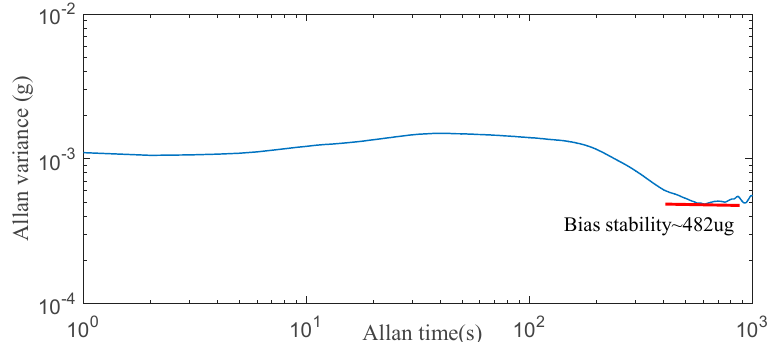
Figure 13. Drift stability curve of z-axis tunneling magnetoresistive accelerometer based on Allan